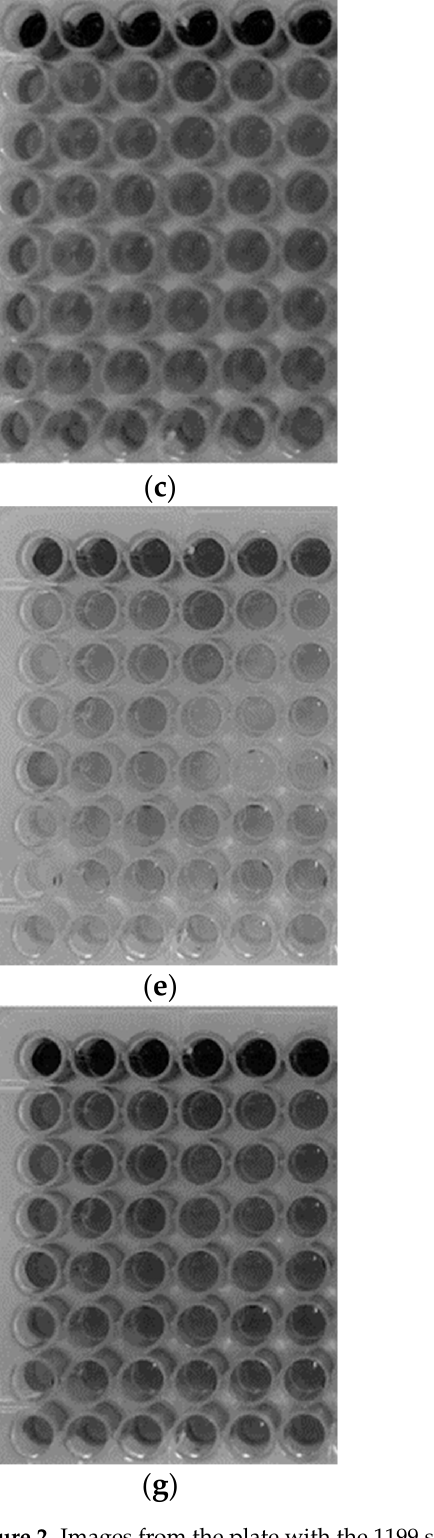
Table 1. The 1199 strain—Gray levels intensity before the addition of resazurin. Concentration (µg/mL)